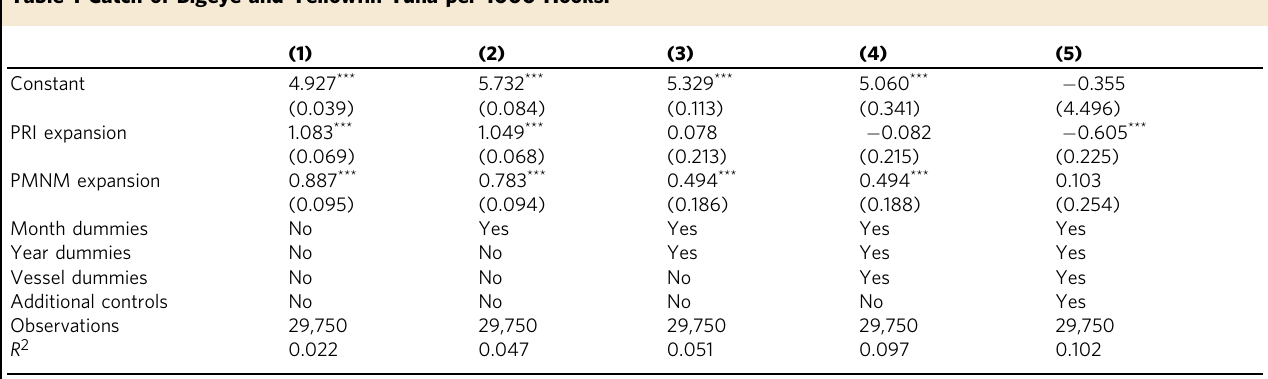
Table 1 Catch of Bigeye and Yellow fi n Tuna per 1000